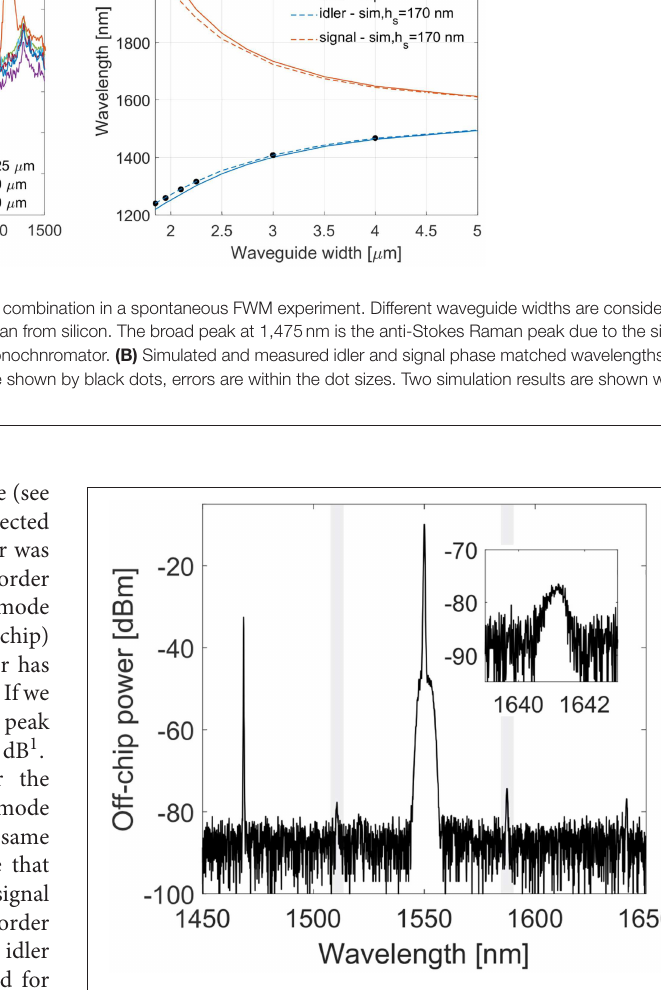
FIGURE 7 | Stimulated inter-modal FWM for the 1221TE combination. The waveguide width is 4 µ m . Spectrum measured at the signal port (see Figure 3 ). The idler CW seed is at 1,468.5nm. The signal is generated at 1,641.1nm. The gray boxes highlight the spurious peaks. In the inset we show the generated signal spectrum. The OSA is here